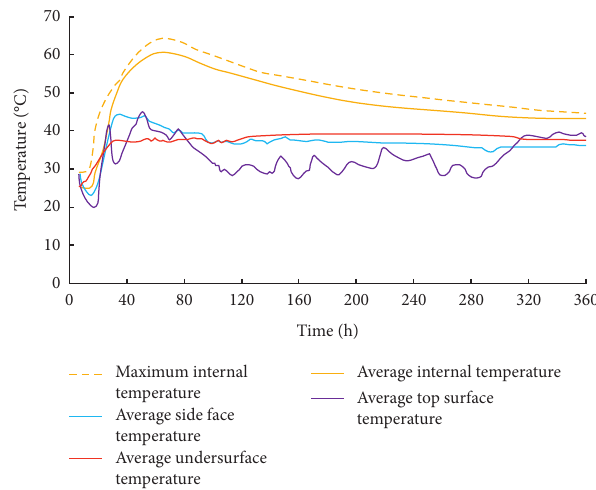
Figure 19: Monitoring results of the first pouring temperature of